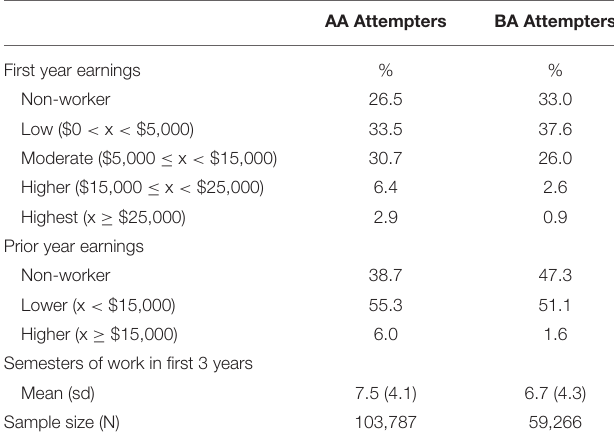
TABLE 2 | Descriptive statistics for students’ first-year earnings and 3 year work